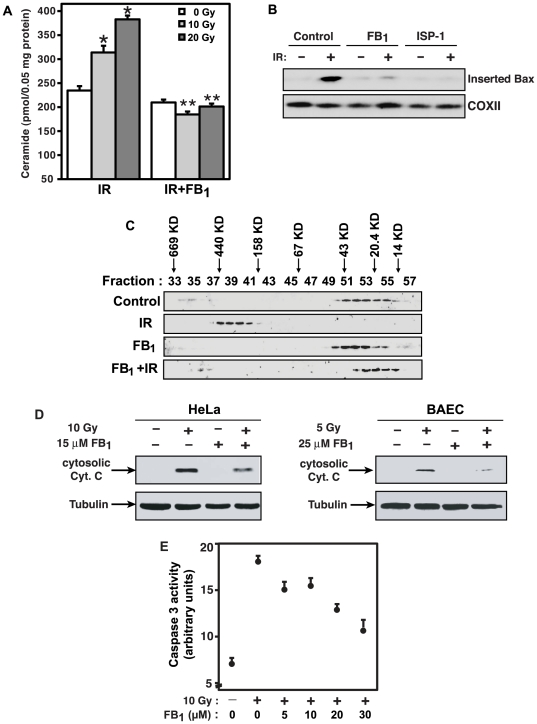
FB1 prevents radiation-induced MOMP in HeLa cells.(A) FB1 blocks mitochondrial ceramide generation. HeLa cells were irradiated (IR) and treated with 15 µM FB1 20 h post-irradiation. Ceramide in isolated mitochondria was quantified by diacylglycerol kinase assay at 36 h post-irradiation. Data (mean±SEM) are from 2 experiments performed in triplicate. *, p<0.05 vs. control; **, p<0.01 vs. irradiated. (B) FB1 prevents radiation-induced Bax insertion into the MOM. Alkali-resistant mitochondrial fractions containing inserted Bax were isolated after 34 h from HeLa cells irradiated with 20 Gy and treated with 25 µM FB1 or 75 nM ISP-1 at 20 h post-irradiation. COXII was used as mitochondrial loading control. Data are from 1 of 4 studies. (C) FB1 blocks radiation-induced Bax oligomerization. At 34 h post-irradiation, mitochondrial proteins from HeLa cells treated as in (B) were separated by gel filtration. Data are from 2 studies. (D) FB1 attenuates radiation-induced cytochrome c release in HeLa cells and BAEC. HeLa cells were irradiated with 10 Gy, and 15 µM FB1 was added 20 h post-irradiation. BAEC cells were treated with 25 µM FB1 1 h before irradiation with 5 Gy. 36 h (HeLa) and 12 h (BAEC) post-irradiation, cytosolic fractions were analyzed by immunoblotting using mouse monoclonal anti-Cyt. c and mouse monoclonal anti-tubulin antibodies. Data are from 1 of 2 studies in HeLa and BAEC each. (E) FB1 attenuates radiation-induced caspase activity. FB1 was added to cells 20 h after 10 Gy and caspase activity measured at 36 h post-irradiation using the fluorogenic caspase substrate Z-DEVD-AFC. Data (mean±SEM) are from 1 of 2 investigations performed in triplicate.